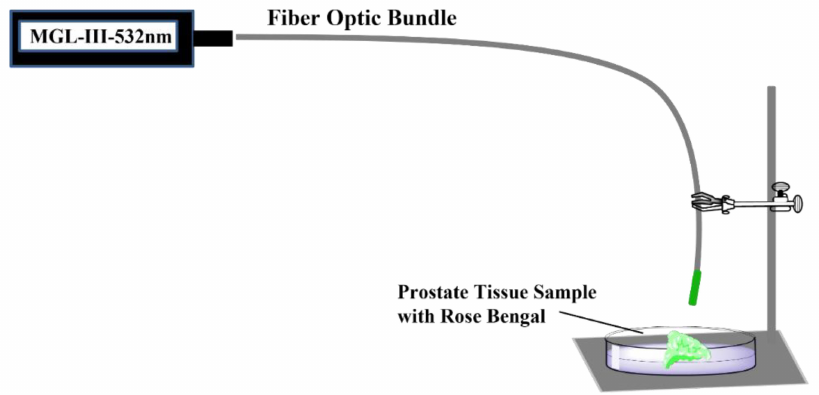
Figure 7. Experimental setup for illumination of RB-coated prostate tissue samples with an MGL-III 532 nm laser and Fiber Optic